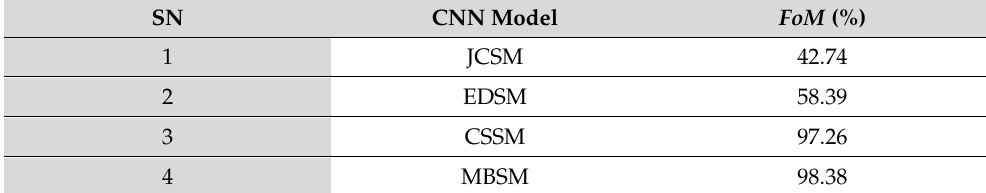
Table 6. FoM was observed for the similarity measures.